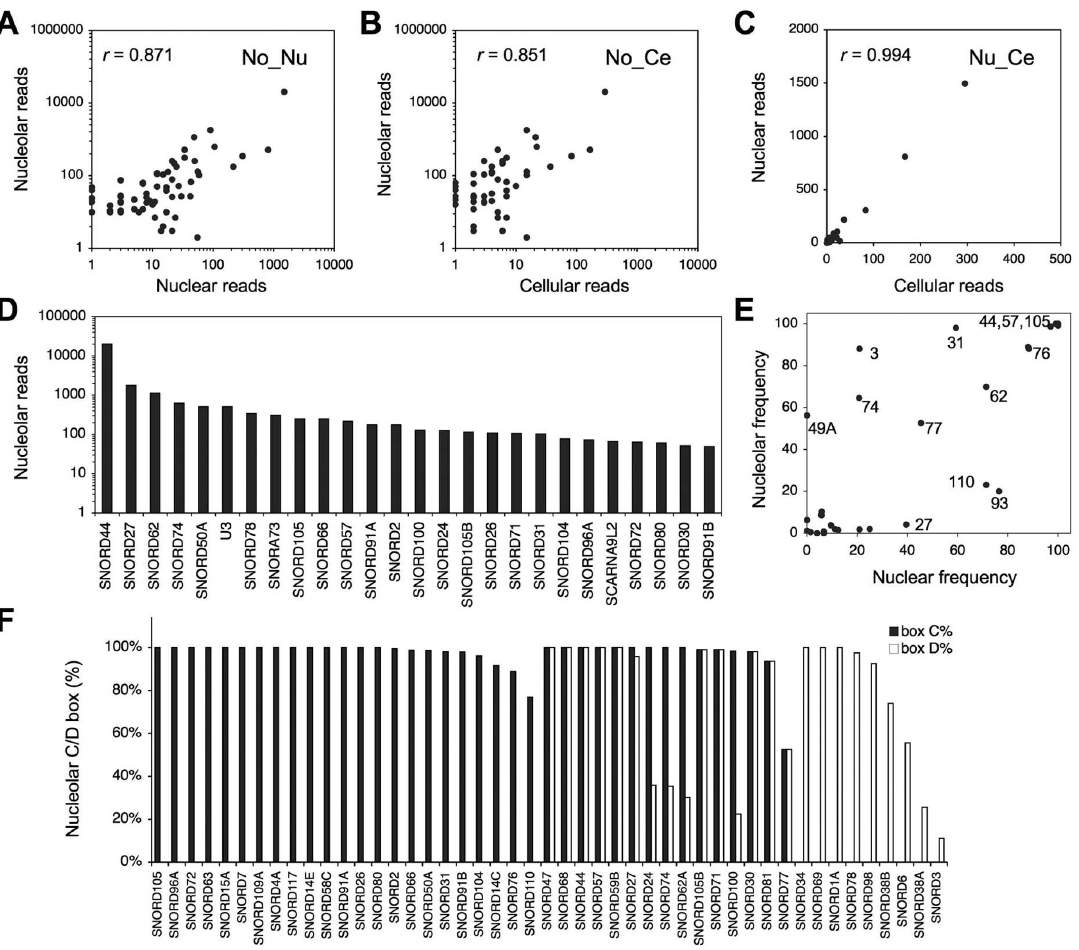
Figure 3. Distribution of sdRNAs in the cellular subfractions. A–C Scatter plots of sdRNA reads in the different cellular compartments. Note the differential scaling of the axes. Pearson correlation coefficiences are indicated ( r ). A Nucleolar (No) vs . nuclear (Nu) sdRNA reads. B Nucleolar (No) vs . whole cell (Ce) sdRNA reads. C Nuclear (Nu) vs. whole cell (Ce) sdRNA reads. D Nucleolar sdRNA reads (reads $ 50 are shown). E Scatter plot of frequencies of nucleolar and nuclear 5 9 reads present at $ 10 reads in both libraries. Selected SNORDs are identified by their numbering. F C/C’ and D/ D’ box frequencies of nucleolar sdRNA reads.